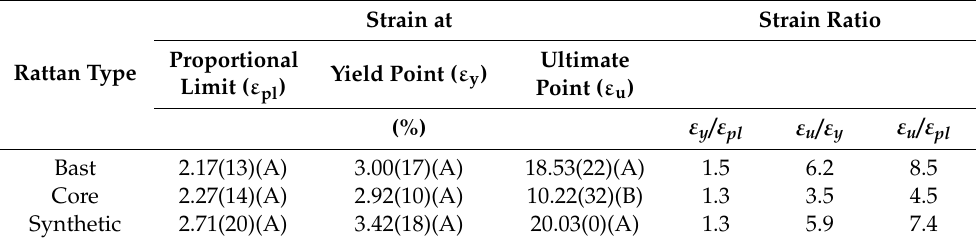
Table 4. Mean values of tensile strains at di ff erent critical points of rattan strips evaluated in test 1 and their mean comparisons for rattan type 1